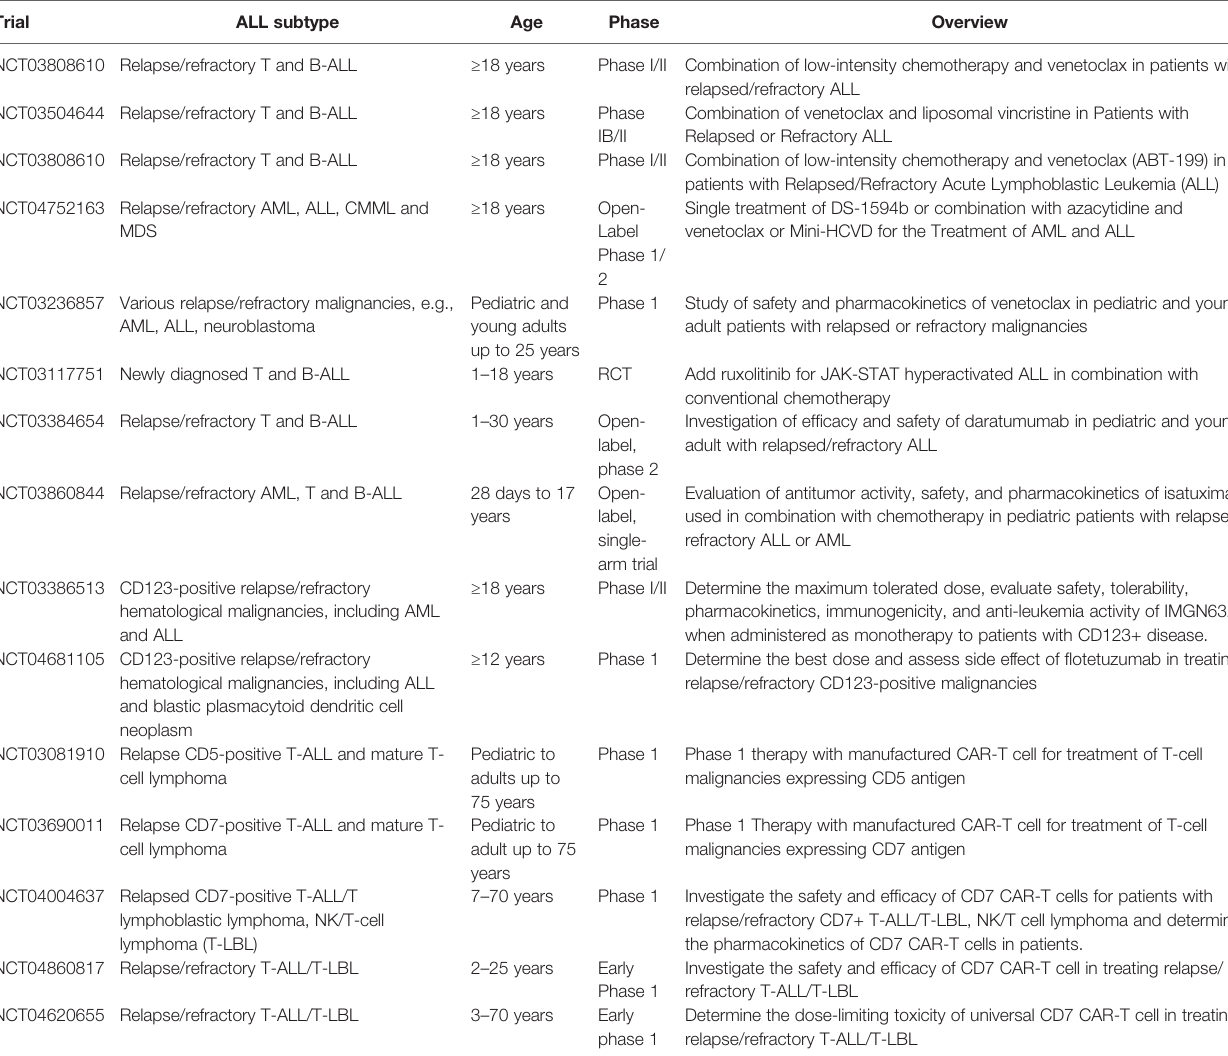
TABLE 9 | Ongoing clinical trials on novel